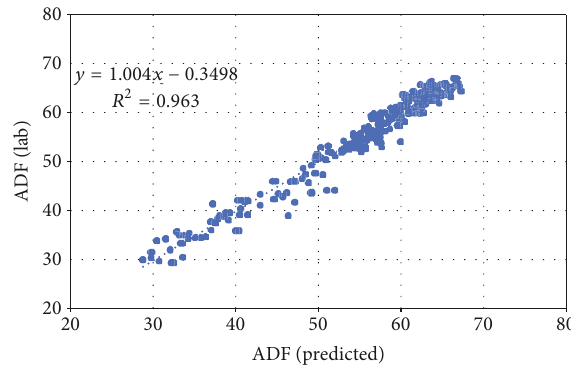
Figure 1: Linear regression relationship between laboratory refer- ence methods and NIRS-predicted values for NDF ( 𝑅 2 = 0.95 ) of winter and spring canola from 2011 on a dry weight basis.